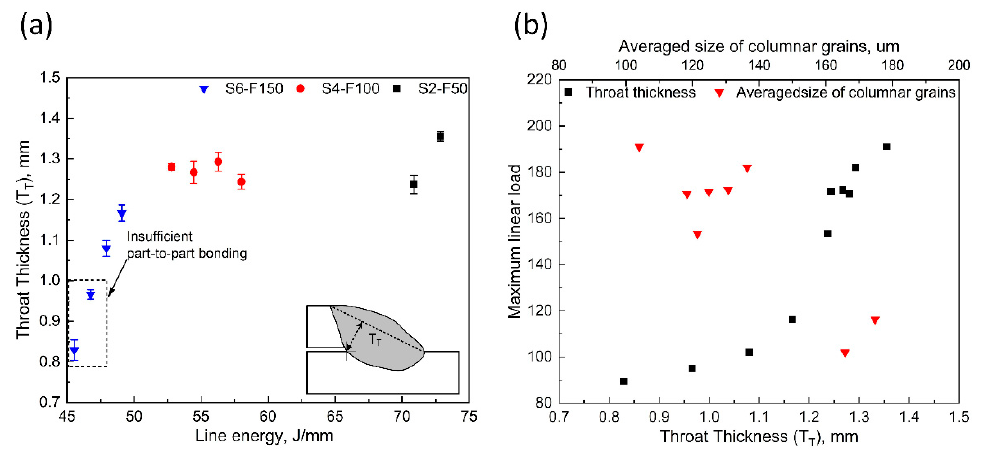
Figure 11. ( a ) Maximum linear load during tensile test and; ( b ) weld zone throat radius as function of welding parameters.